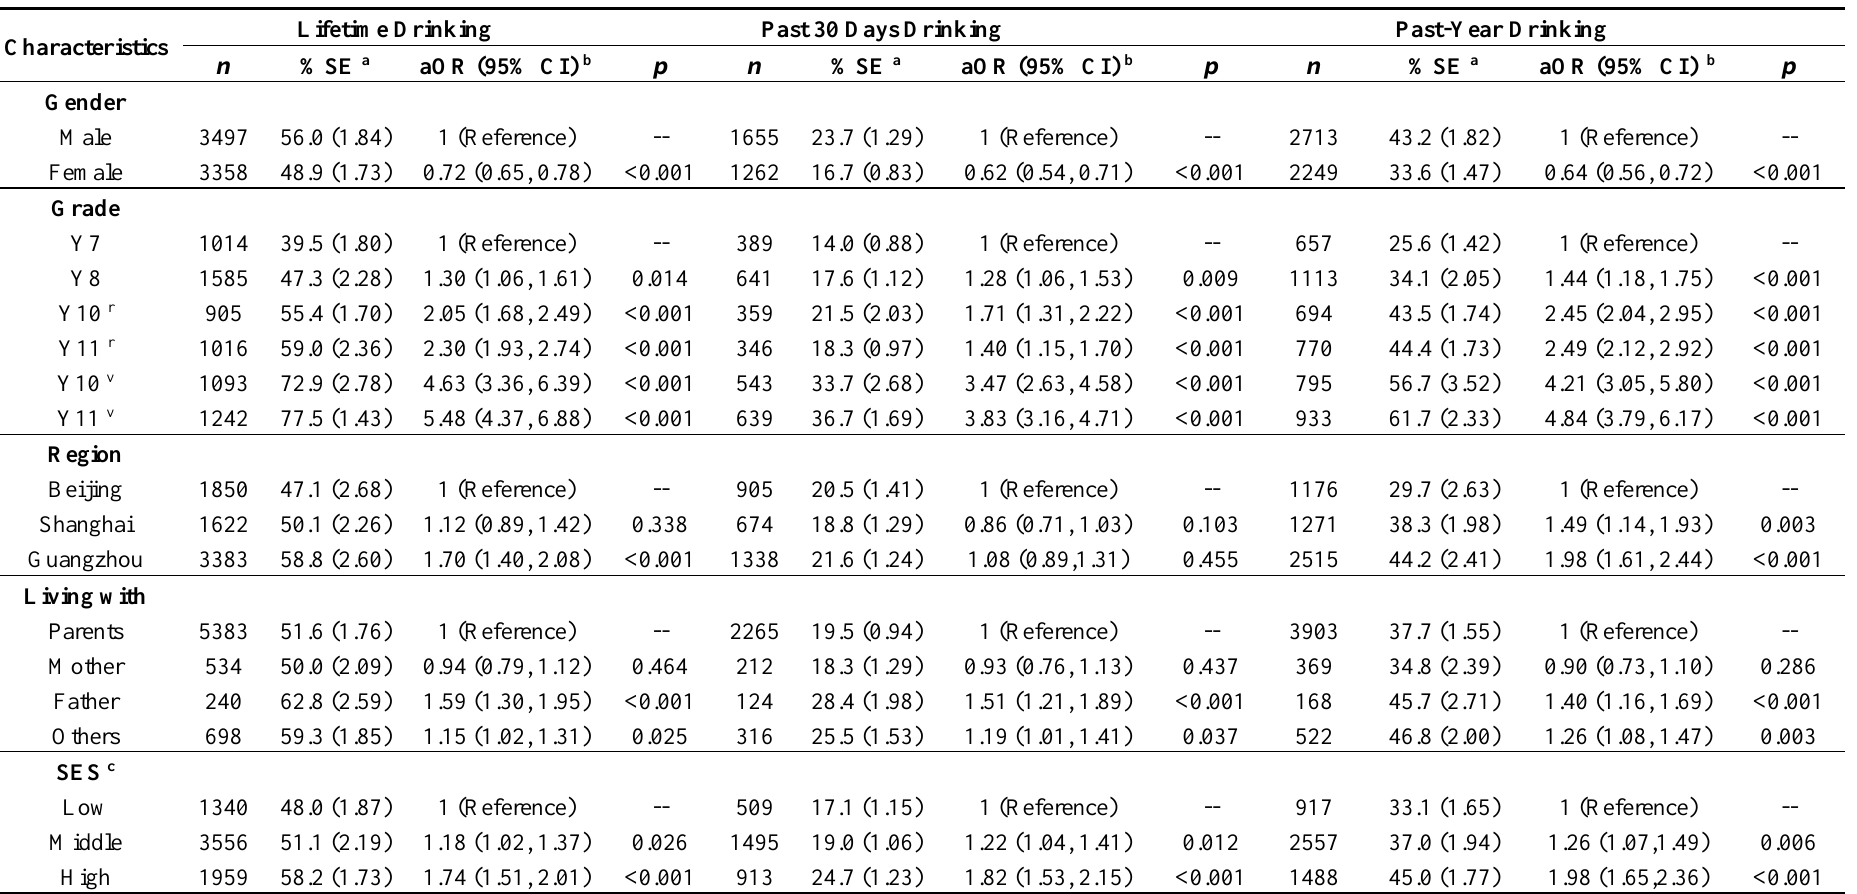
Table 4. Prevalence, adjusted odds ratios, and 95% confidence interval of lifetime drinking, drinking in the past 30 days and drinking in the past year by socio-demographic